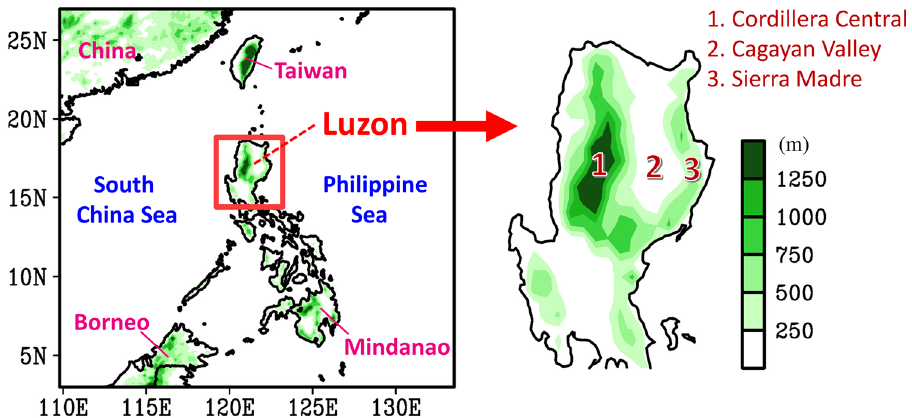
Figure 1. Geographic locations and topography over East Asia (left panel) and Luzon (right panel). This figure is created using the software of Grid Analysis and Display System version 2.1.1.b0 (hereafter GrADS v2.1.1.b0), available at http:// cola. gmu. edu/ grads/ downl oads.